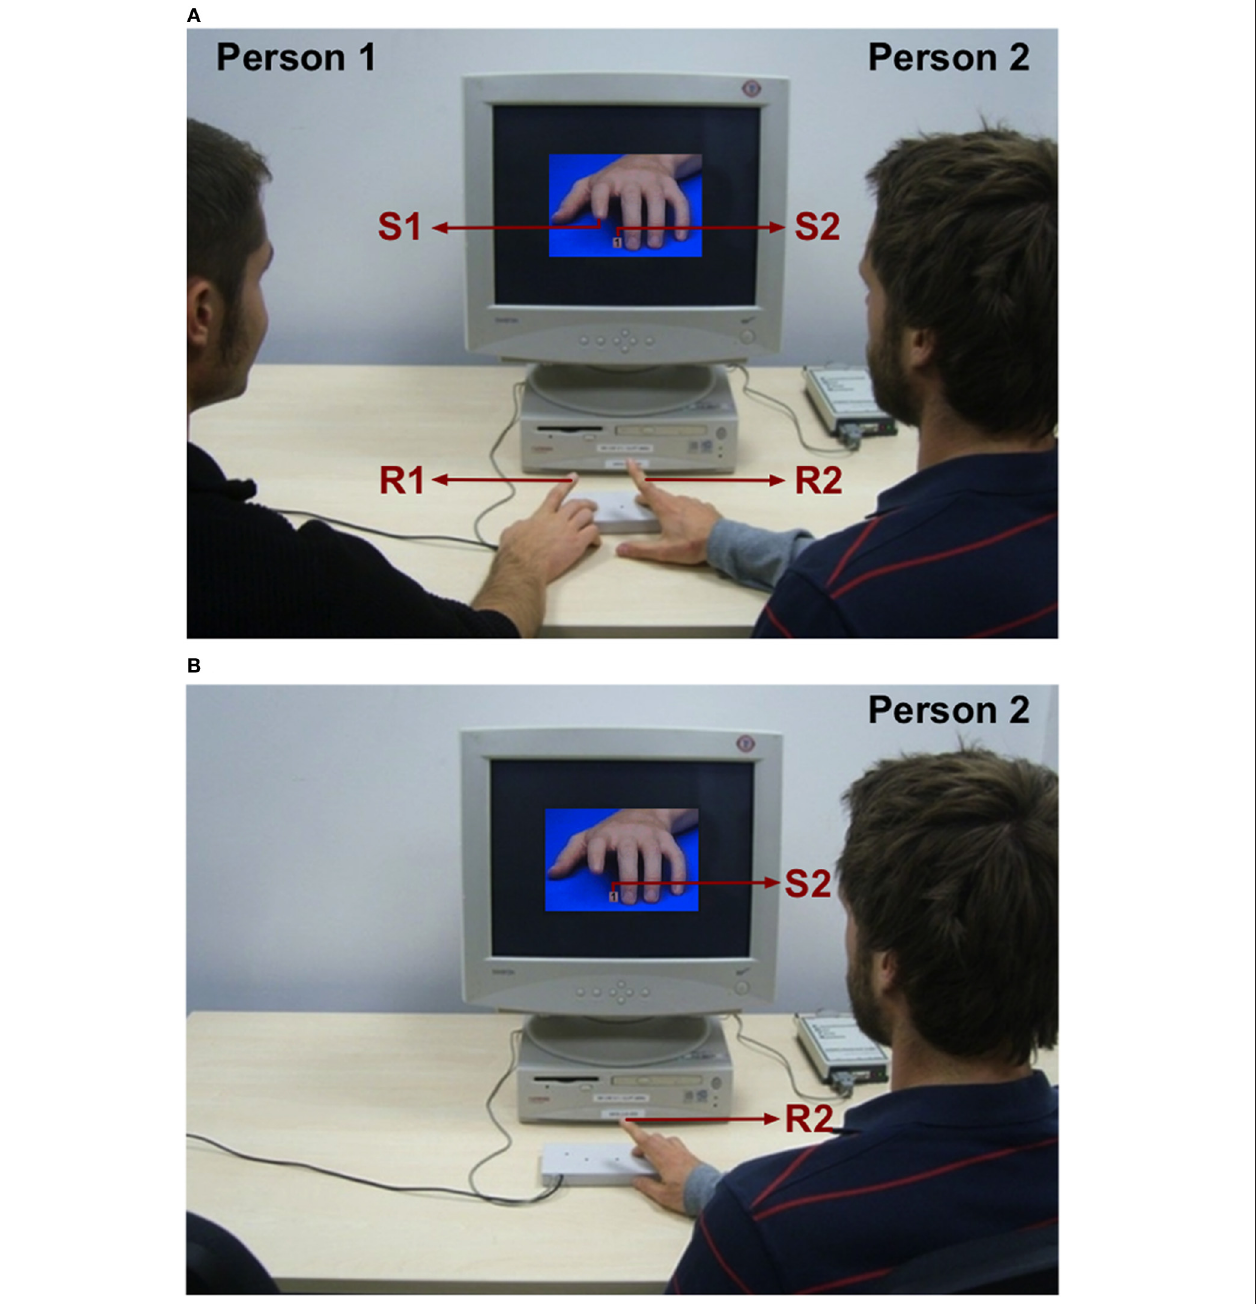
FIGURE 1 | Experimental setup. Each participant performed one part of a dual-task. Person 1 (acting on Task 1) sitting on the left side had to execute finger-lifting movements (R1) with his right index or middle finger in response to a hand stimulus (S1). Person 2 (acting on Task 2) sitting on the right side